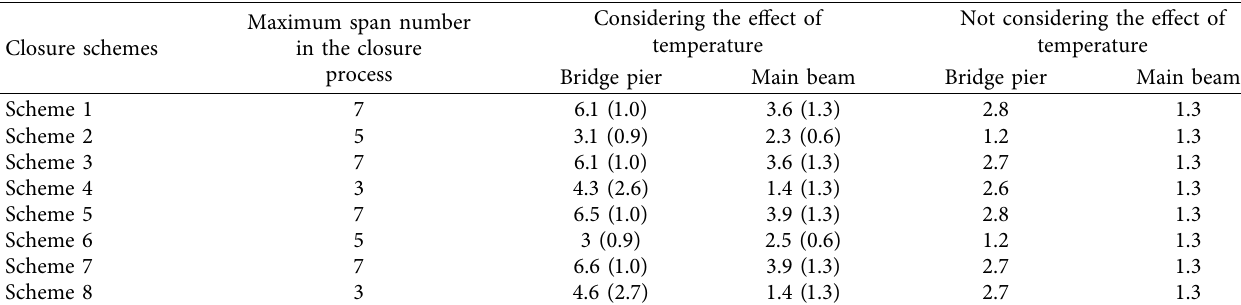
Table 7: Each closure scheme considers/does not consider the maximum stress (MPa) of the main beam and pier under the action of temperature.